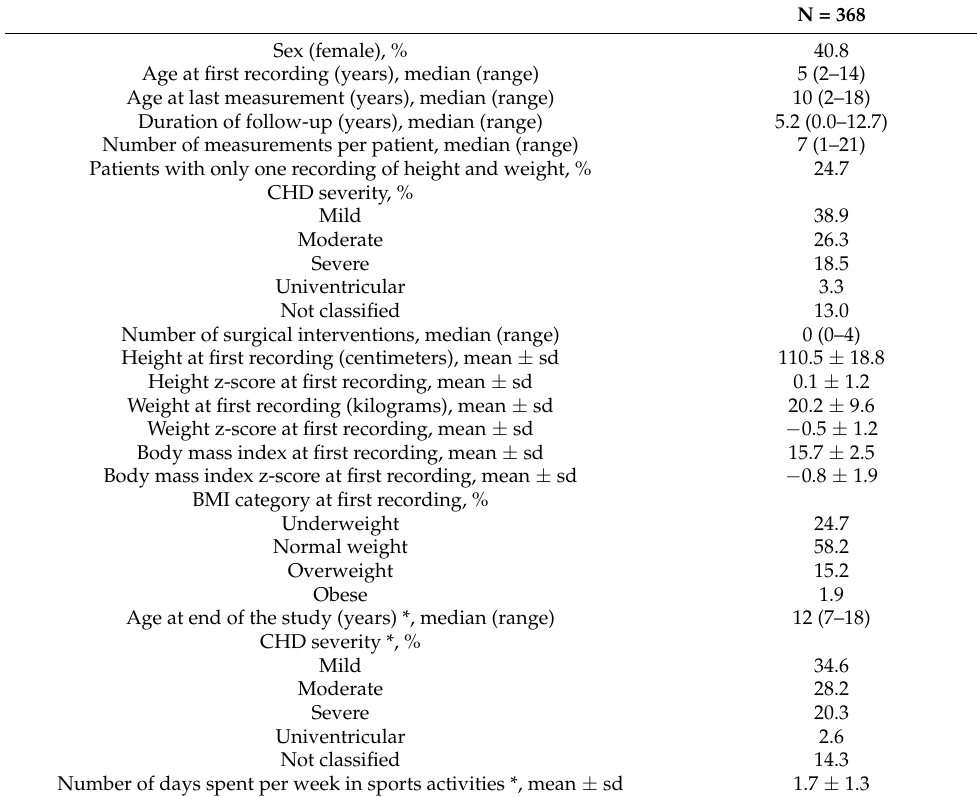
Table 1. Main characteristics of patients included in the analysis.